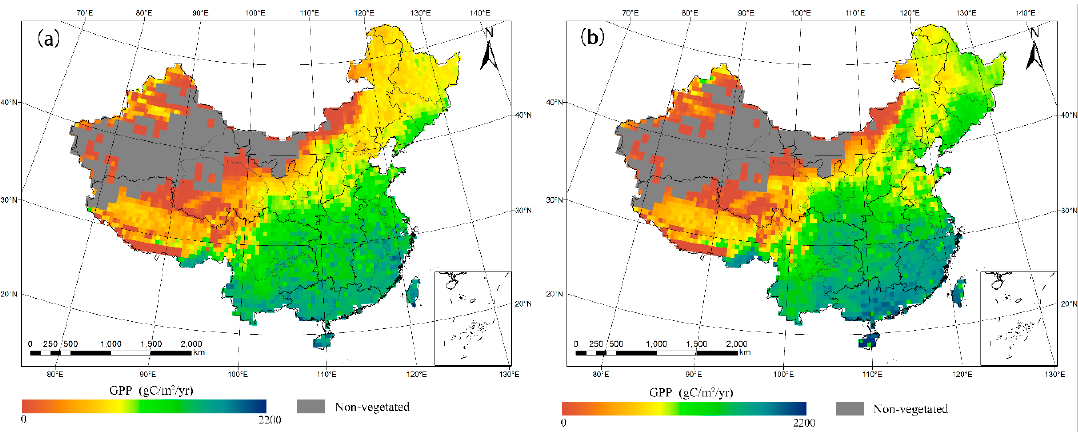
Figure 8. Spatial distribution of gross primary productivity (GPP) in China for year: ( a ) 2003; and ( b ) 2012.